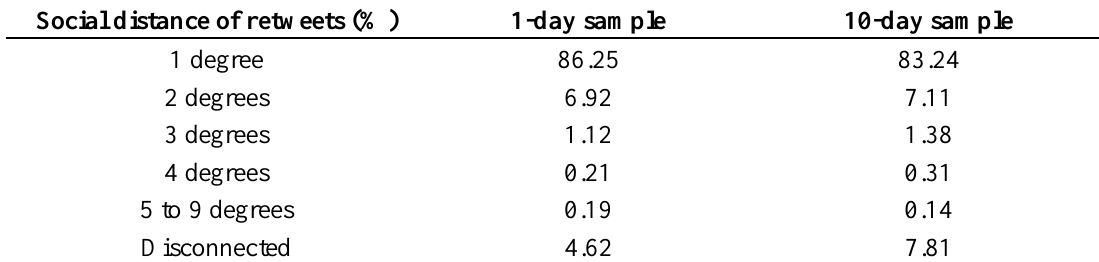
Table 4. Social distance traveled by retweeted